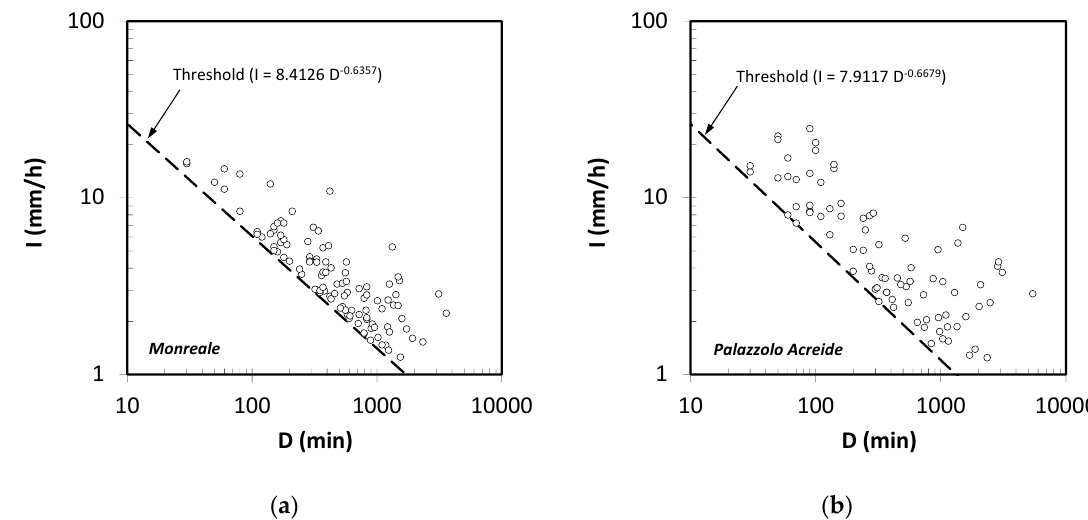
Figure 2. Events selected for the study with the threshold curve at: ( a ) Monreale; ( b ) Palazzolo Acreide.